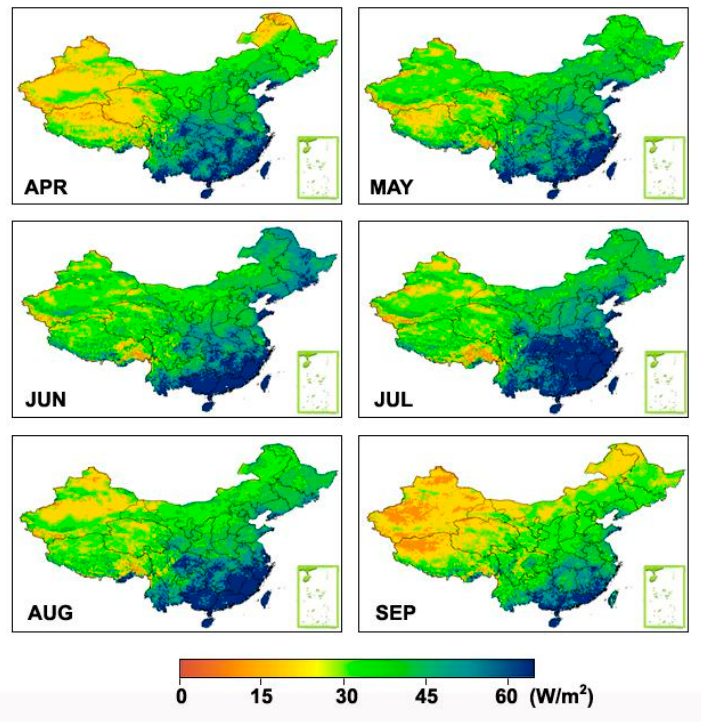
Figure 1. Monthly composites of daily evapotranspiration for April to September of 2004 over China [48].